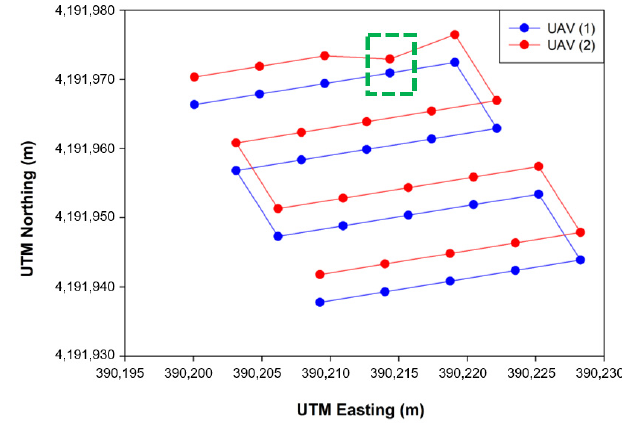
Figure 12. Flight path to verify collision avoidance algorithm.